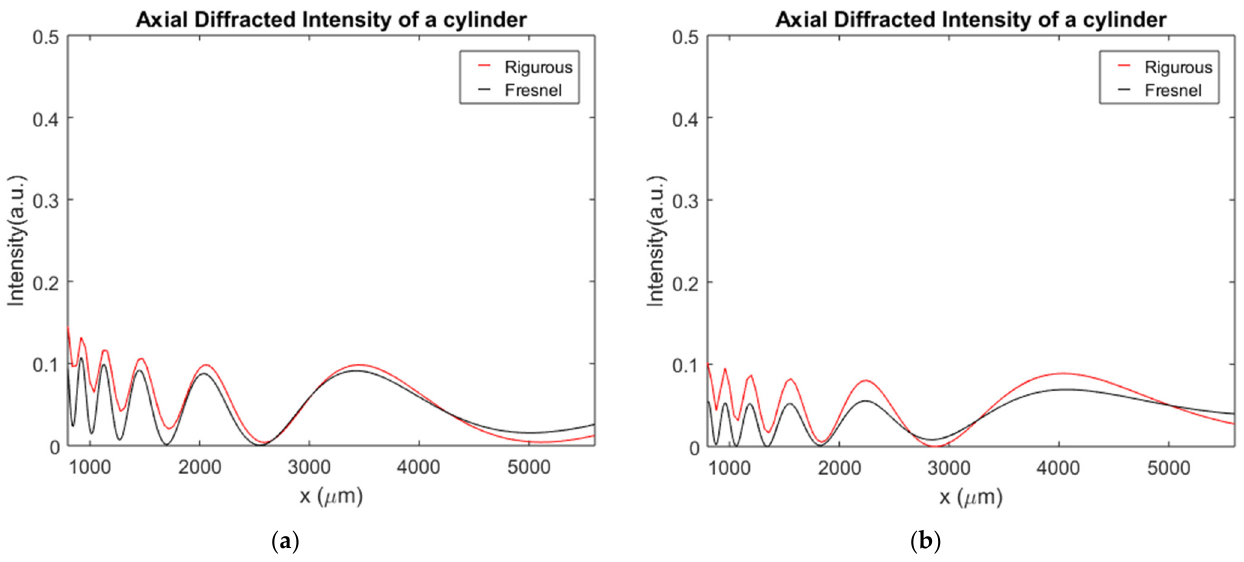
Figure 6. Intensity of the diffraction pattern as function of the axial distance z for a dielectric cylinder with internal radius a = 80 µm: ( a ) with refractive index n = 1.85; ( b ) with refractive index n = 3.4.